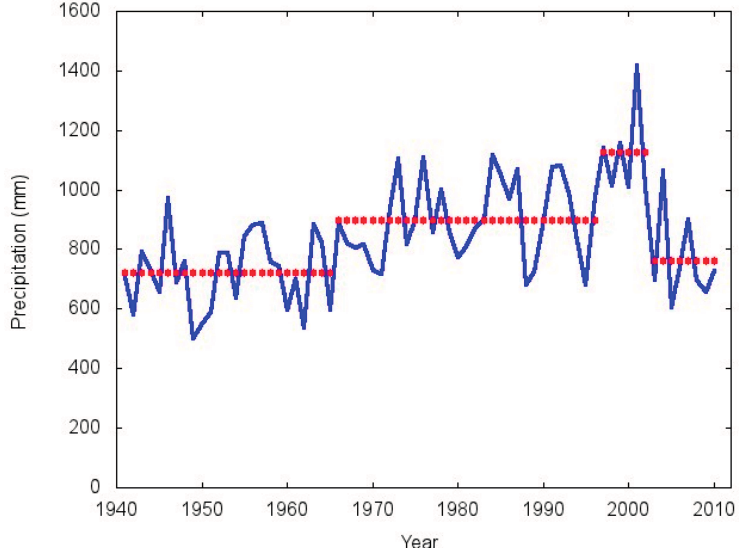
Figure 7. Annual precipitation and means for sub-periods in the Central Pampa sub region by Hubert’s segmentation method.